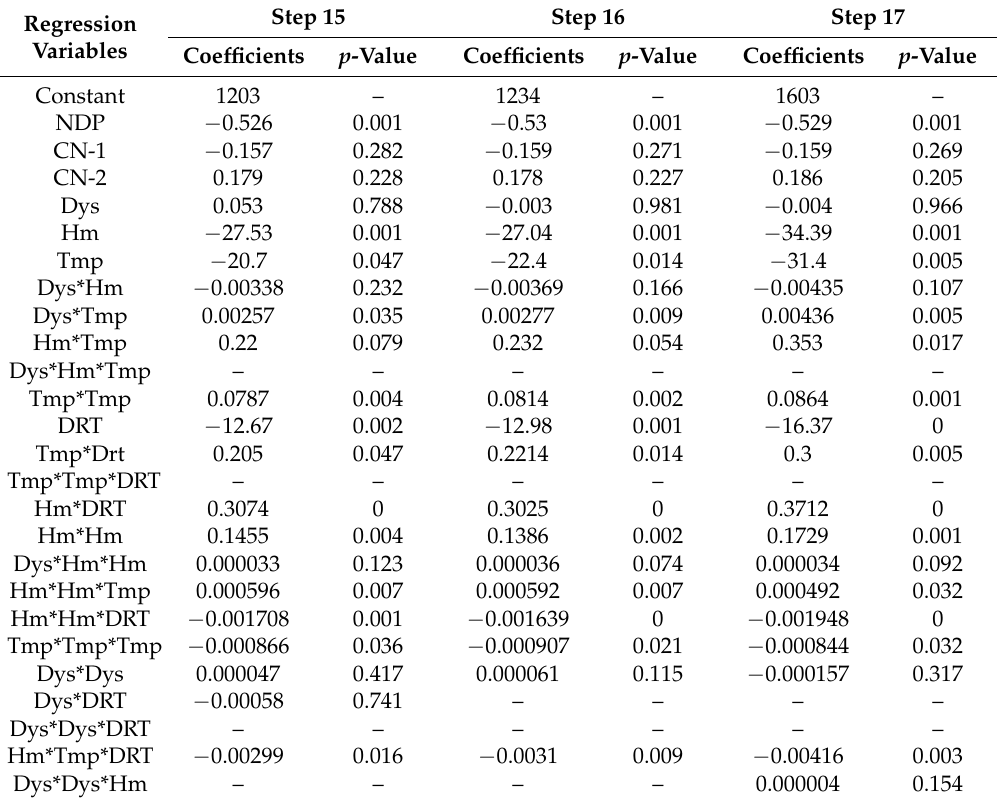
Table 6. Step wise selection procedure results.